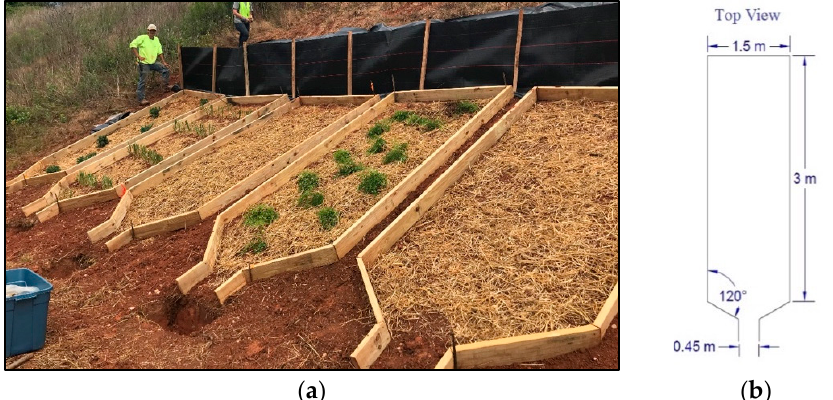
Figure 3. Completed experimental plot after installation and planting with plots 1–5 shown left to right ( a ) and plot dimensions ( b ).